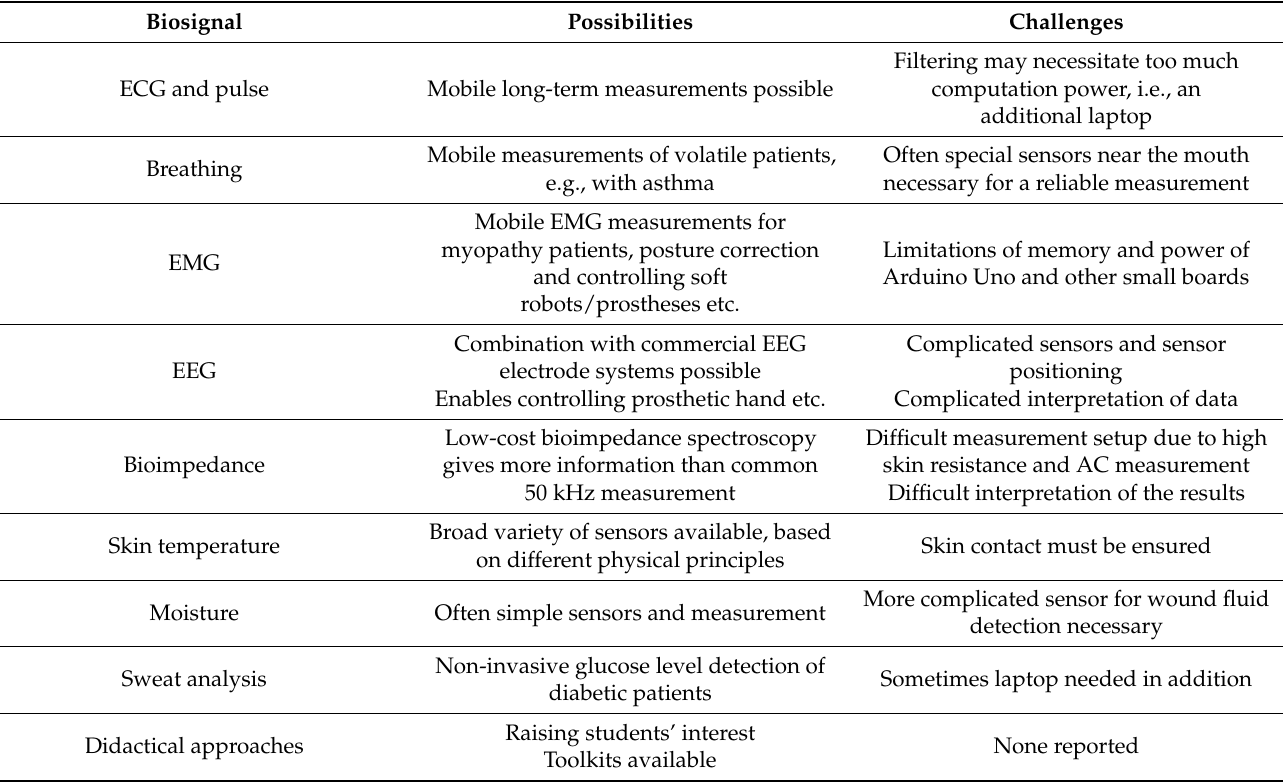
Table 1. Possibilities and challenges of measuring different biosignals with single circuit